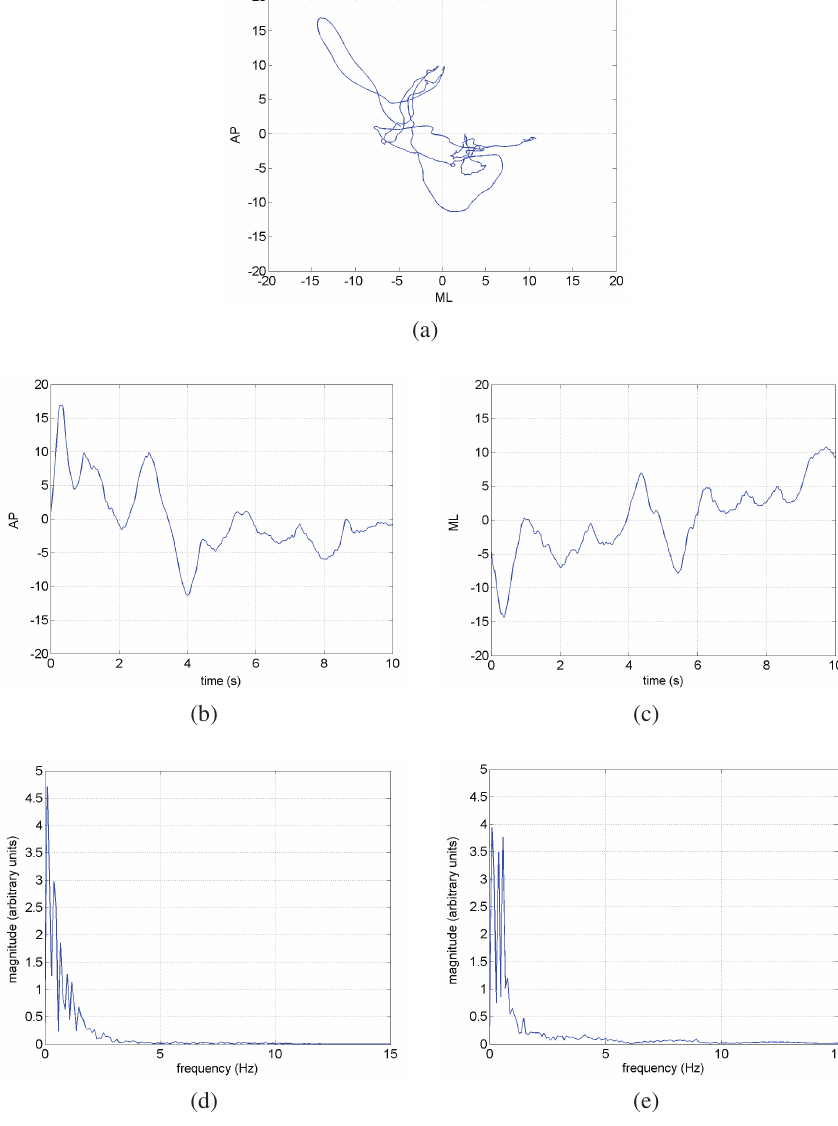
Figure 2. Center of pressure data for a typical control subject. Data were sampled at 100 Hz. (a) COP signal, (b) AP signal, (c) ML signal, (d) Fourier spectrum of AP signal, and (e) Fourier spectrum of ML